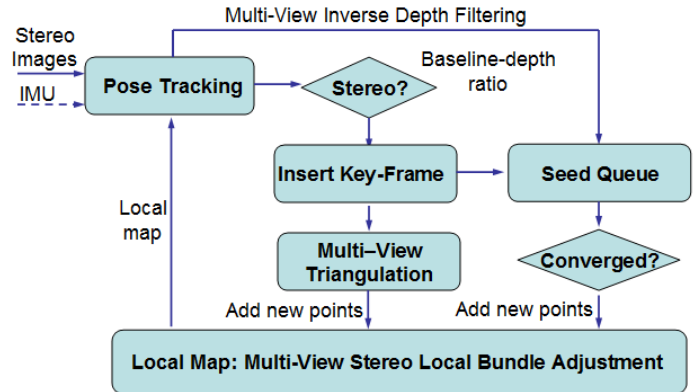
Figure 1. Long-range visual odometry